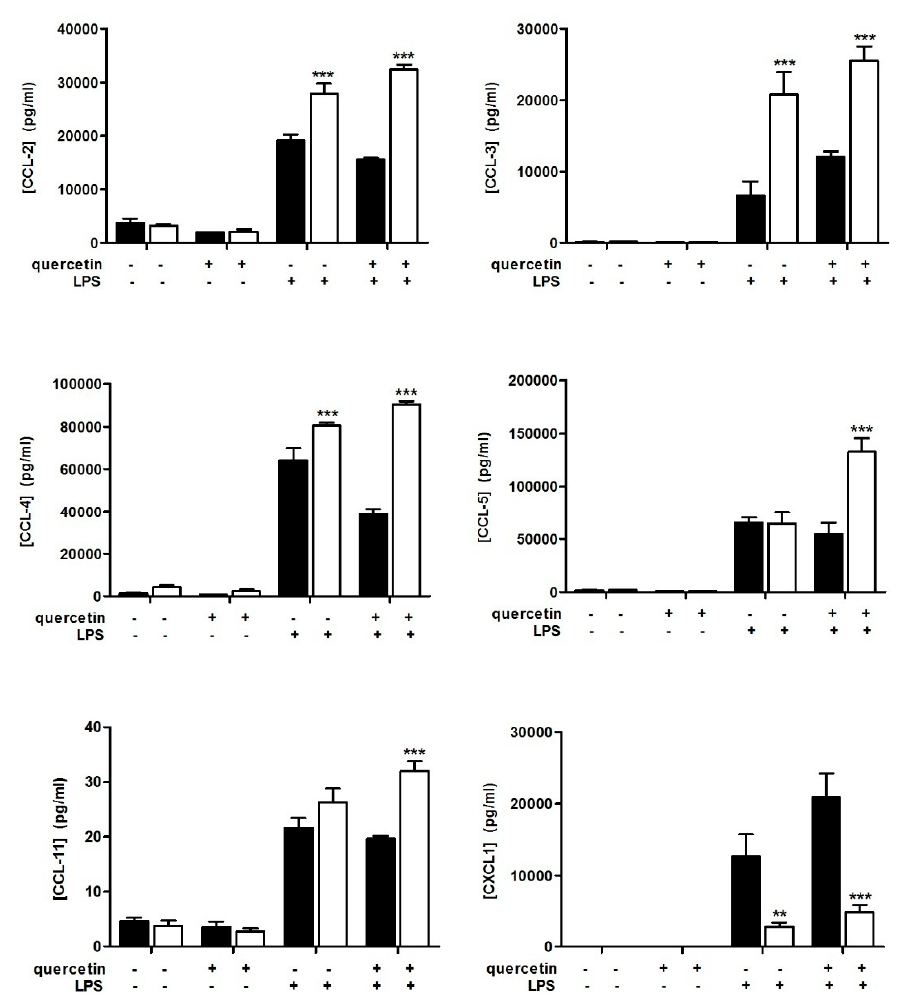
Figure 2. Quercetin exposure and chemokines release. Slpi-KO DCs fail to release the chemokine (C-X-C motif) ligand-1 CXCL-1 following LPS administration independently from quercetin exposure. BMDCs were cultured from WT (black bars) and Slpi-KO (white bars) mice, treated with quercetin at day 5 and 7 and exposed to LPS. Secretion of chemokines was determined after 24 h by Multiplex assay. Bars represent mean concentration of the (C-C motif) ligand-2, -3, -4, -5, -11 (CCL-2, CCL-3, CCL-4, CCL-5, CCL-11) and CXCL-1 ± SEM ( n = 4). *** p < 0.001, ** p < 0.01.